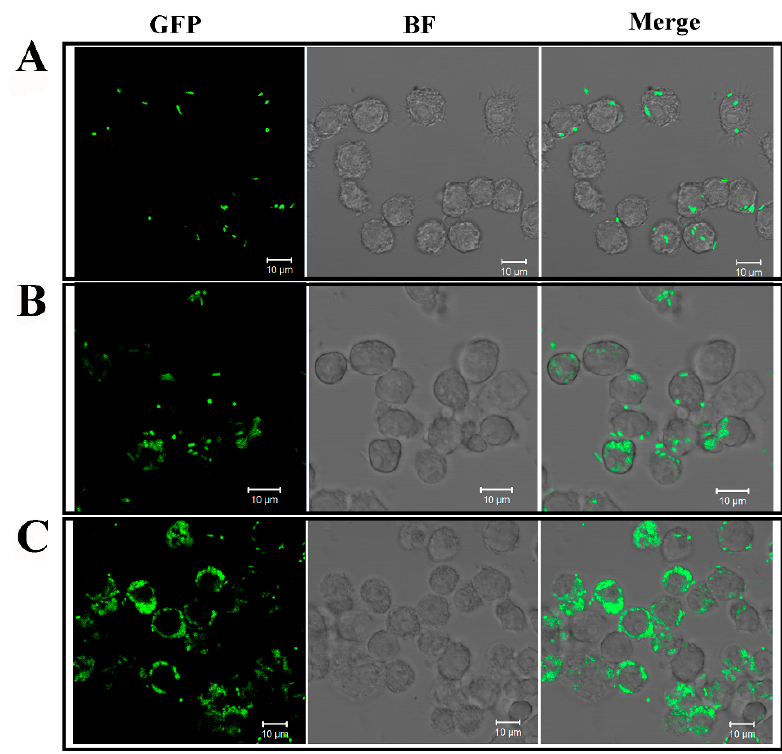
Figure 1. Microscopic observation of the intracellular replication of Edwardsiella tarda in RAW264.7 cells. RAW264.7 cells were infected with GFP-expressing E. tarda for 2 h. The extracellular and surface-attached bacteria were killed by antibiotic treatment. The cells were then incubated for 0 h ( A ), 4 h ( B ), and 8 h ( C ) to allow intracellular bacterial replication. After incubation at each time point, the cells were observed with a confocal microscope under bright field (BF) and fluorescent light (GFP). The merged image of each panel is shown on the right. Scale bar, 10 µm. Table 1. Summary of the sequencing data. C, control groups; D, dead E. tarda -treated groups; L, live E. tarda -treated groups; 4 h, 4 h post infection (hpi); 8 h, 8 hpi. Each sample was triplicated as indicated by the number after the hyphen, e.g., C4h-1, C4h-2, and C4h-3.